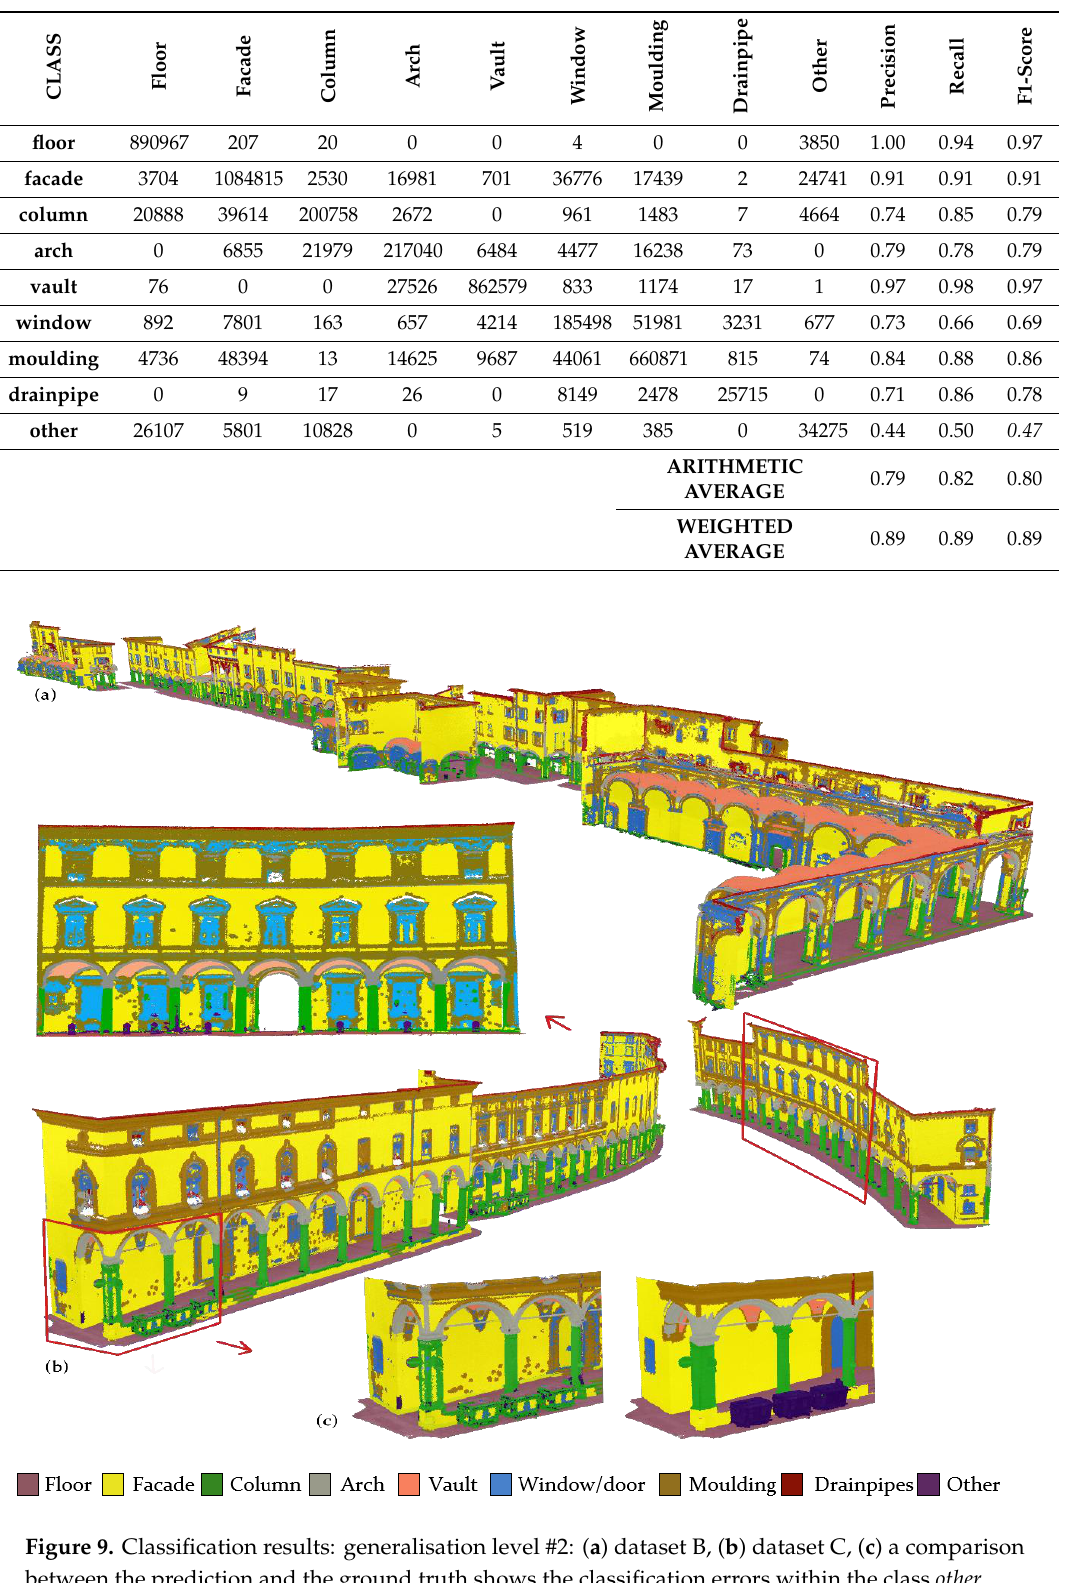
Table 4. Evaluation metrics: generalisation level #2, B–C datasets. The most critical F1 values are reported in italics ( other class).